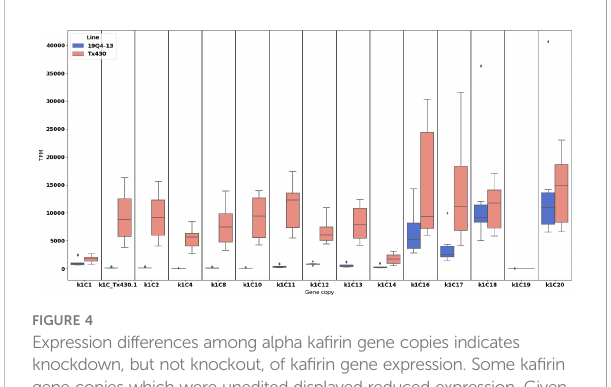
FIGURE 4 Expression differences among alpha ka fi rin gene copies indicates knockdown, but not knockout, of ka fi rin gene expression. Some ka fi rin gene copies which were unedited displayed reduced expression. Given the considerable structural variation, disruption in regulatory sequences may be preventing normal transcription of the unedited gene copies. TPM in the y-axis represents